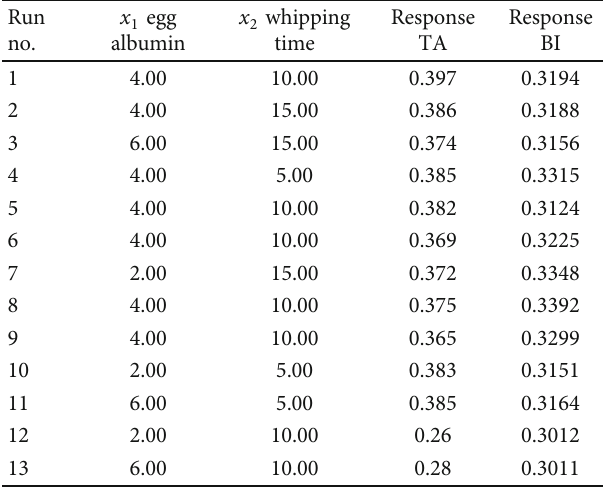
Table 3: Central composite face center design corresponding responses, TA (g %) and BI (%) with x x = whipping time 2